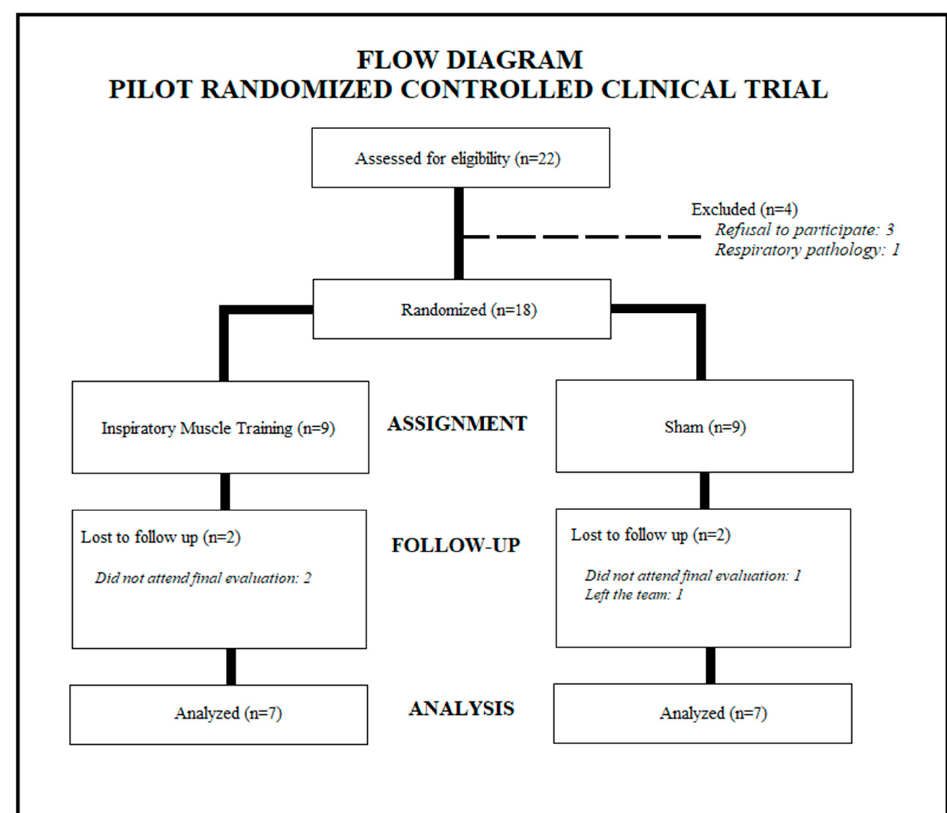
Figure 1. Participant selection and randomization process.